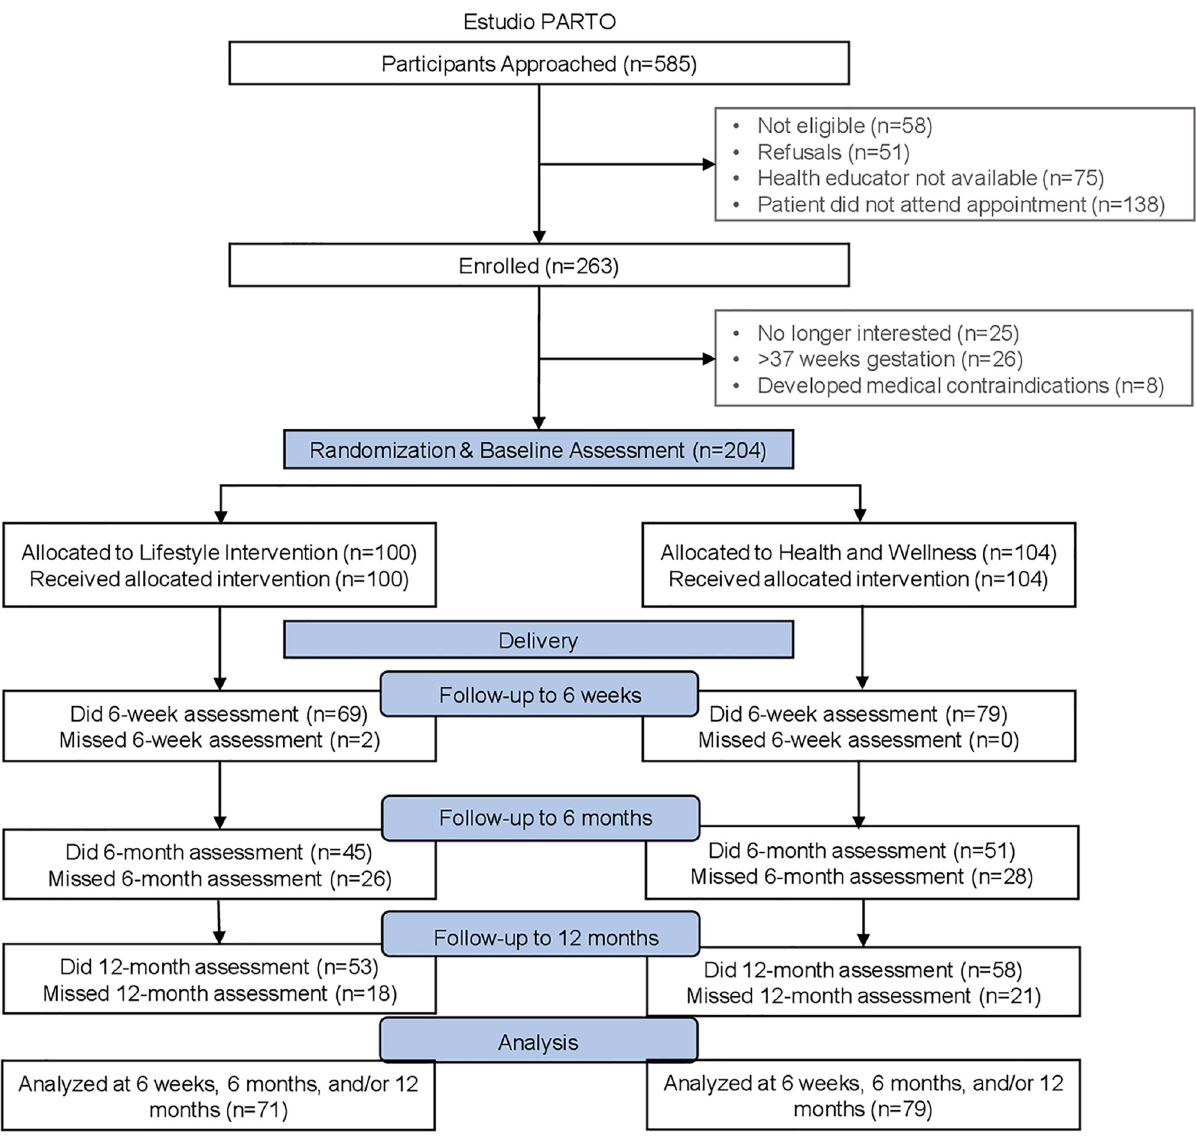
Fig 1. Flow chart of participant recruitment and retention; Estudio PARTO